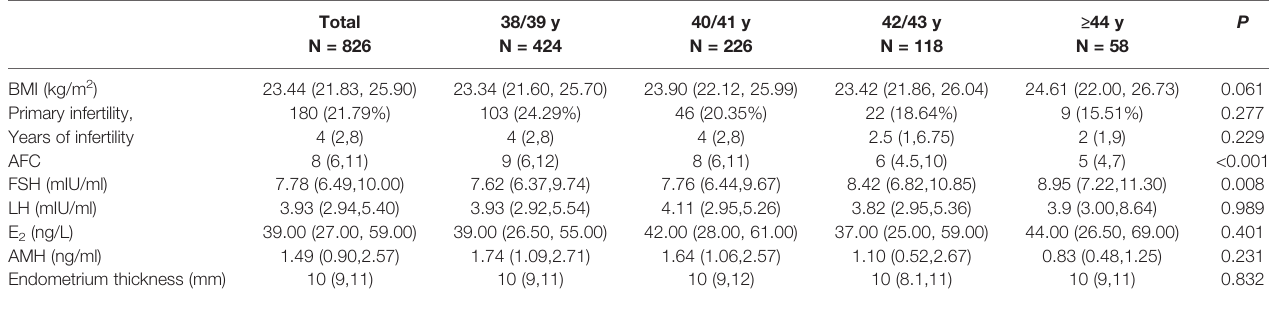
TABLE 4 | Baseline characteristics in different age brackets.